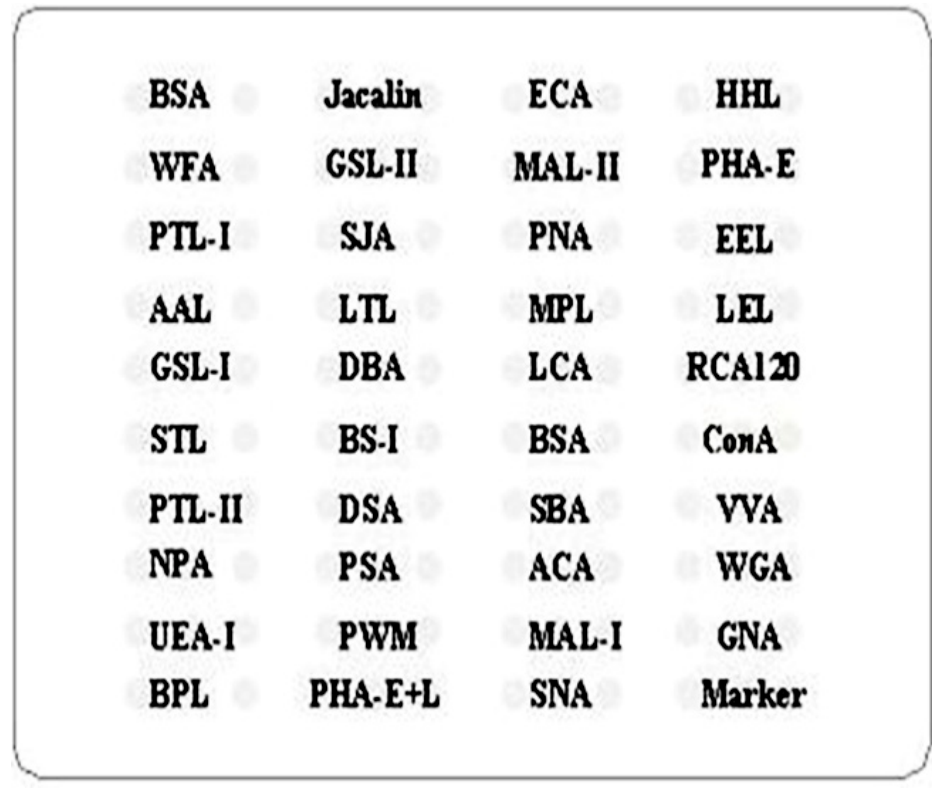
Figure 7. Layout of saliva or serum lectin microarray containing 37 lectins, the negative control, bovine serum albumin (BSA), and a marker.